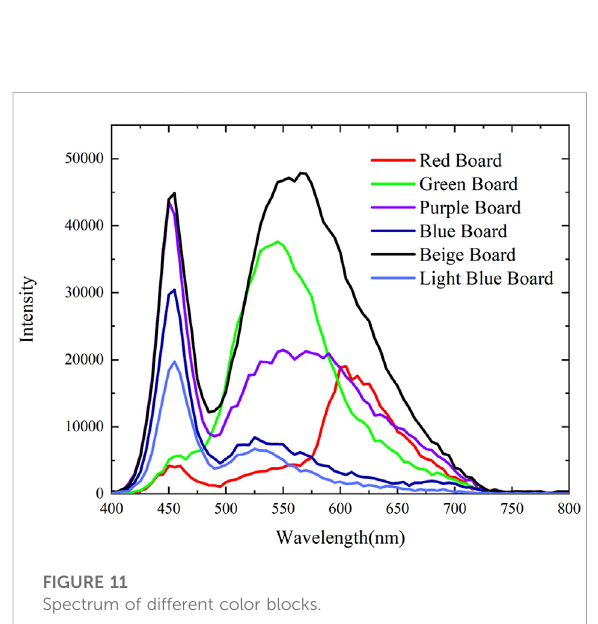
FIGURE 12 Spectrum of the standard light source.